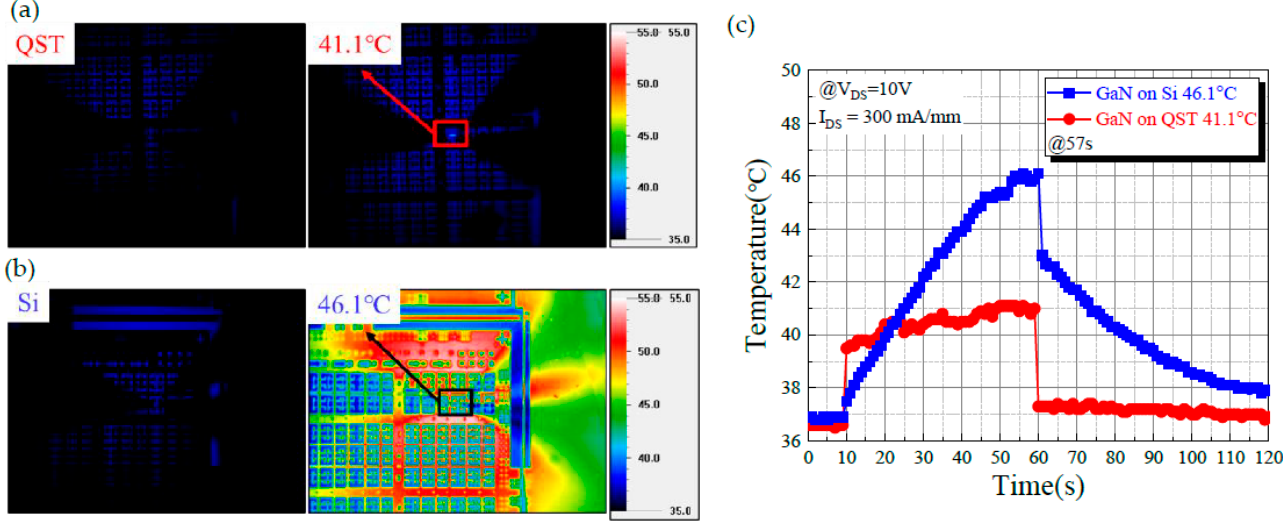
Figure 5. Analysis of the thermal image measurements for ( a ) GaN on QST and ( b ) GaN on Si, and ( c ) The analysis of the thermal behavior at an I DS of 300 mA/mm.